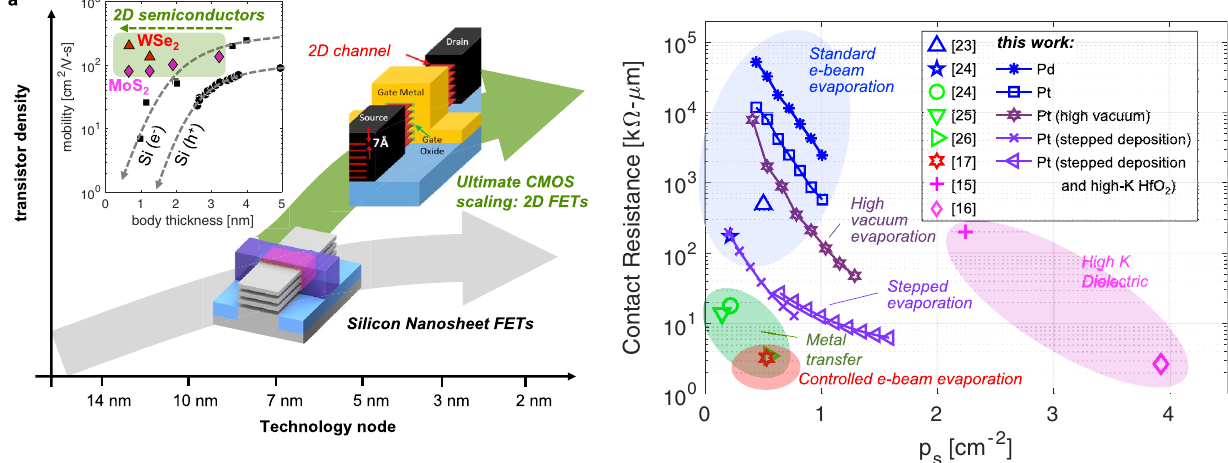
Figure 1. ( a ) Roadmap for introduction of 2D materials in CMOS technology to enhance scaling, density of integration, and chip performance, as well as to enable new functionality (e.g., in CMOS + X), and 3D monolithic integration. Two tracks are shown, one for silicon gate-all-around (GAA) FETs with stacked nanosheets (each sheet ~ 5 nm in thickness), and one for FETs with stacked 2D nanosheets (< 1 nm thickness for monolayer semiconductors) © [2021] IEEE. Reprinted, with permission, from 15 . Inset shows mobility degradation with scaling the both thickness in Si devices (e.g., the nanosheet thickness), while 2D semiconductors shown negligible degradation down to a monolayer. ( b ) Summary of trends on improvements of 2D PMOS FET contact resistance as function of sheet carrier density and the methods to achieve those improvements. Results from this work show advances in contact resistance from standard e-beam evaporation to high-vacuum and stepped evaporation on devices with scaled high-K dielectric and metal gate (HKMG)